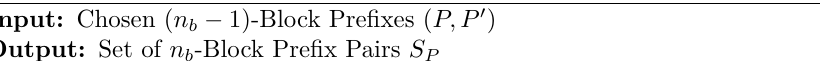
Algorithm 16 Generating n b -Block Prefix